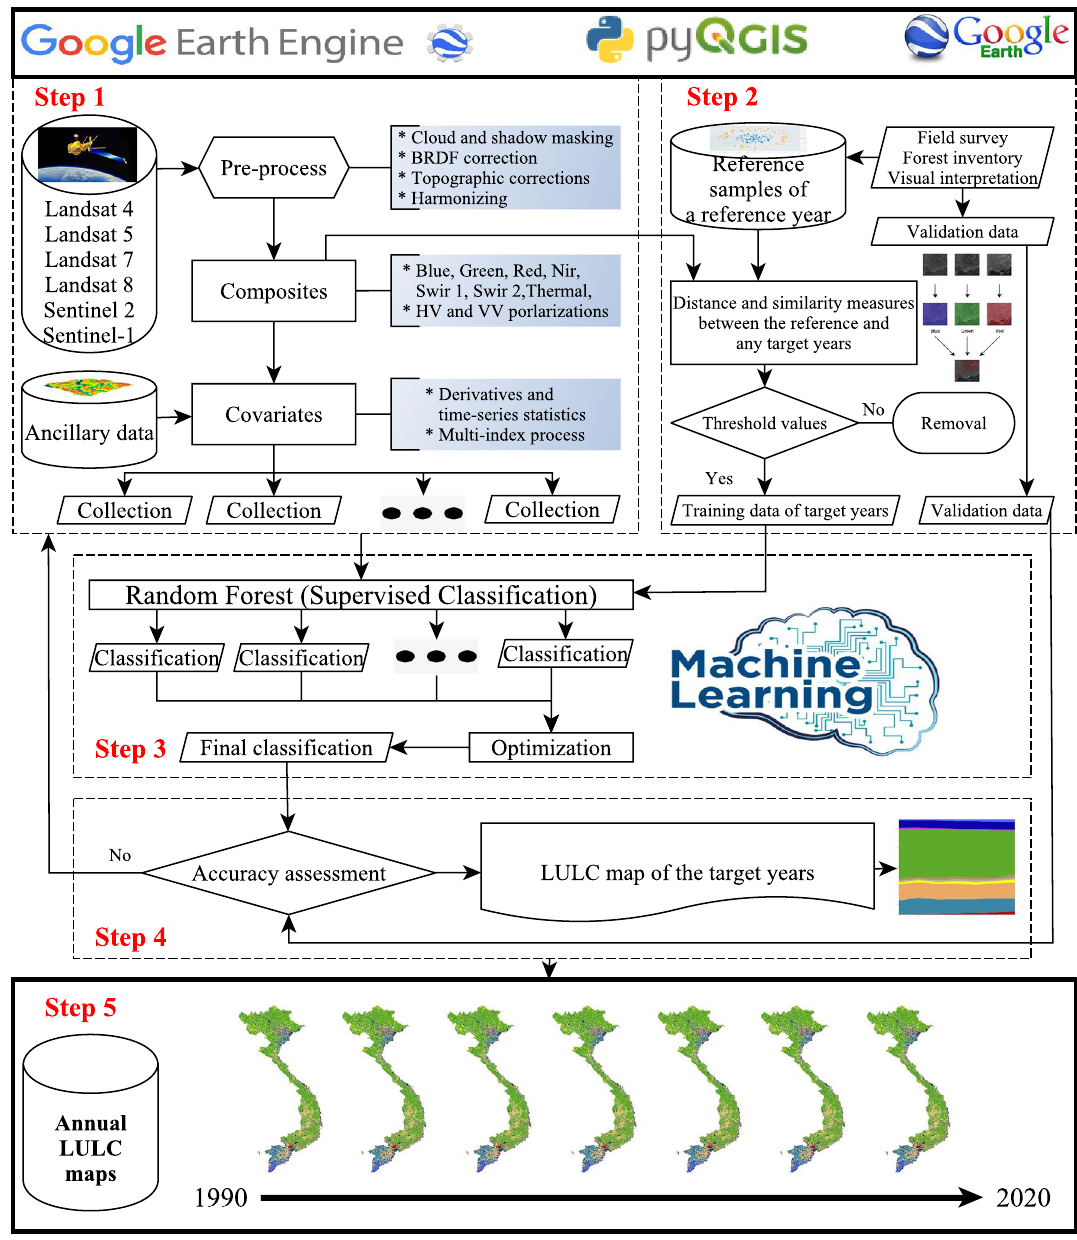
Figure 10. The overall workflow for automatic Vietnam-wide annual land use/cover mapping and monitoring, using Landsat TM, ETM + and OLI, and Sentinel SAR GRD and MSI images with the random-forest-based algorithm. This figure is generated using yEd Graph Editor (https:// www. yworks. com/ produ cts/ yed). The logos of the Google Earth Engine, pyQGIS, Google Earth, and Machine Learning is taken from https:// earth engine. google. com/, https:// autom ating- gis- proce sses. github. io/ site/ devel op/ lesso ns/ L7/ overv iew. html, https:// logos. fandom. com/ wiki/ Google_ Earth, and https:// www. pngit em. com/ middle/ hRJJR RJ_ machi ne- learn ing- course- near- me- machi ne- learn ing- logo/,